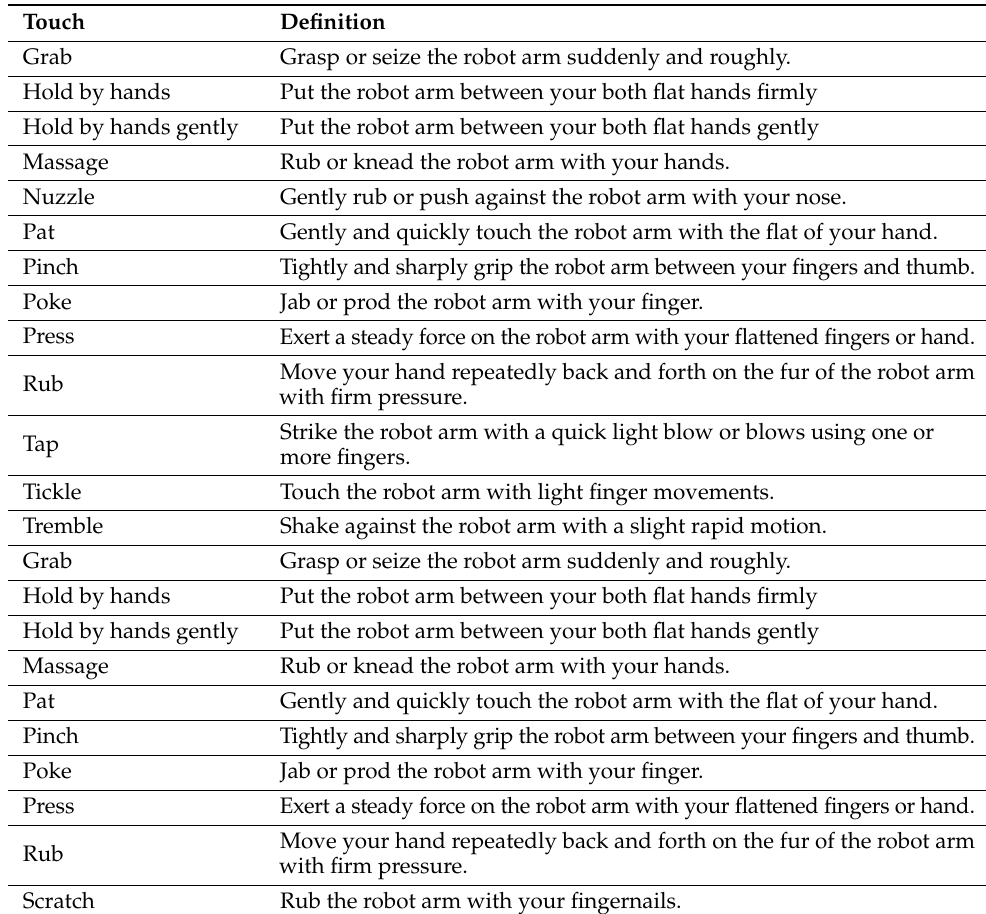
Table 1. Touch gestures dictionary